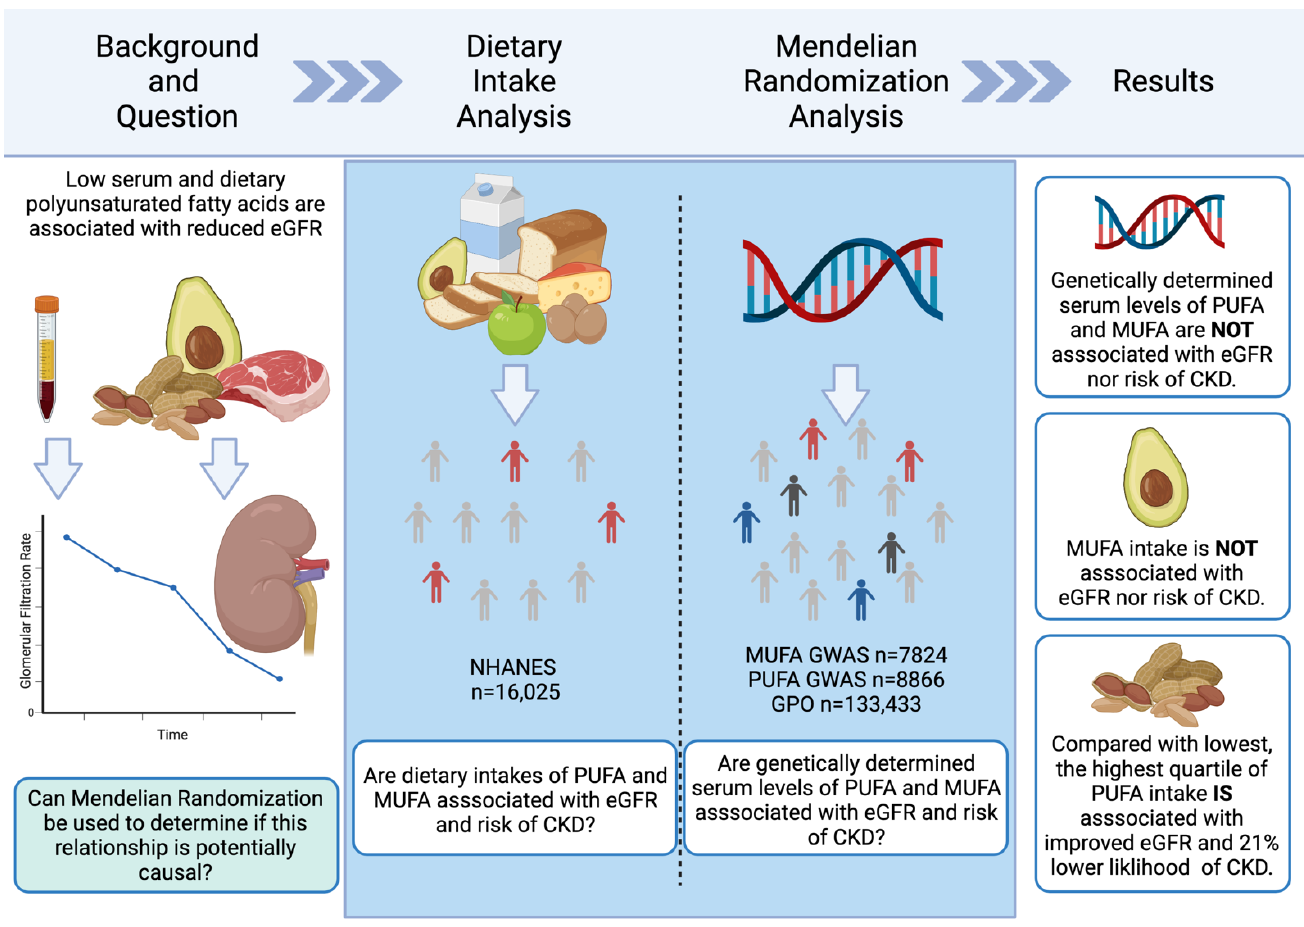
Figure 1. Graphical summary of the study methodology and results. eGFR: estimated glomerular filtration rate; NHANES: Nutrition and Health Examination Survey; PUFA: polyunsaturated fatty acid; MUFA: monounsaturated fatty acid; CKD: chronic kidney disease; GWAS: genome-wide association study; GPO: genetic predictors of outcomes.